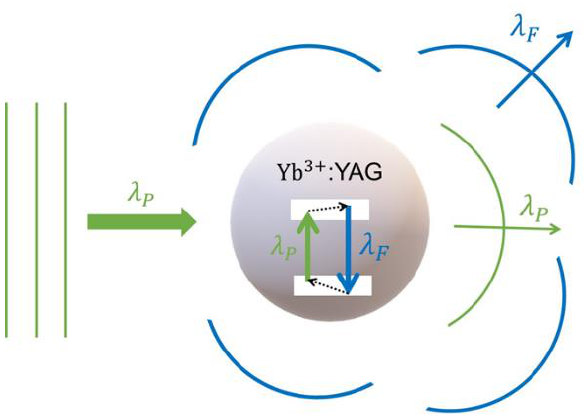
Figure 3. System under investigation. Here, 𝜆 𝑃 and 𝜆 𝐹 are the pump and mean fluorescence wave- lengths, respectively [29]. π R 3 is the volume of the sphere. R is the radius of the sphere. The cooling where V = 4 3 power density, ρ cool , for nanospheres with different radii in the range between 150 nm and 650 nm was estimated using relations (22) and (23). The results are plotted in Figure 4. It changes considerably on this range and has several peaks. The radii of the nanospheres corresponding to these peaks are very close to the resonant radii of the Mie resonant modes including the magnetic dipole (MD) modes, the magnetic quadrupole (MQ) modes, the electric dipole (ED) modes, and the electric quadrupole (EQ) modes.